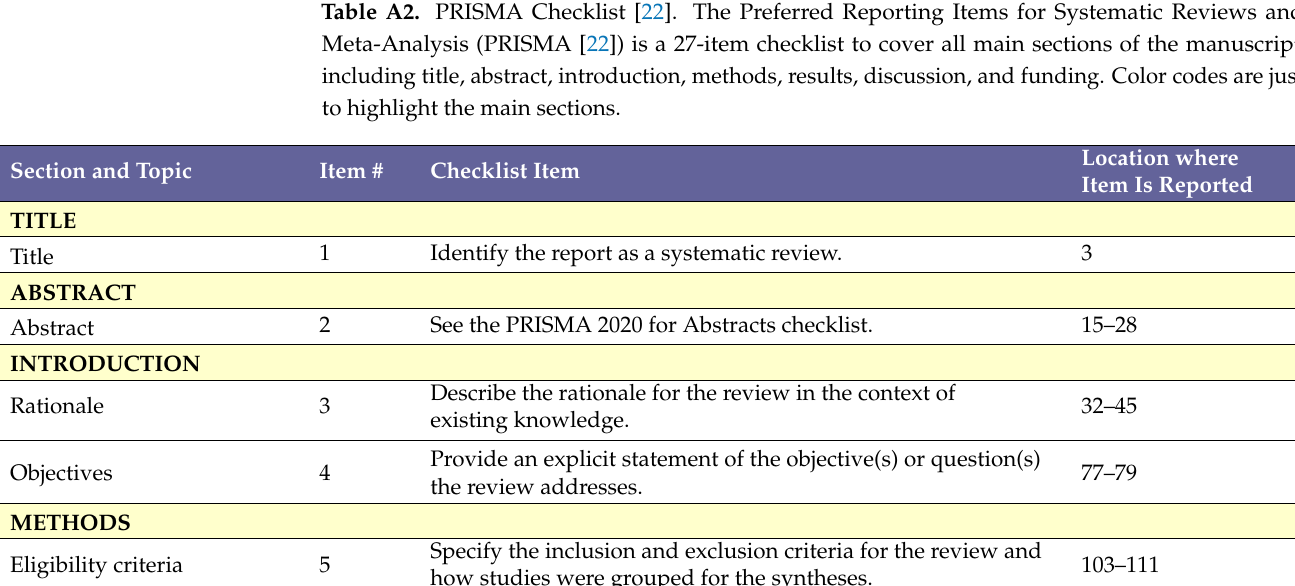
Table A2. PRISMA Checklist [22]. The Preferred Reporting Items for Systematic Reviews